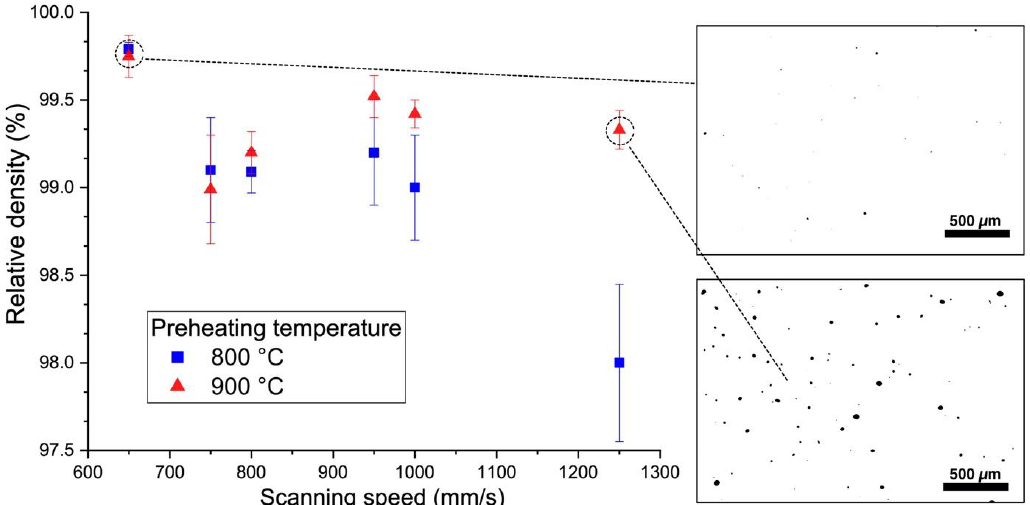
Figure 5. Effect of scanning speed and platform preheating temperature on the relative density of the samples fabricated from MAPS powder with cross-section images showing typical pore distribution. Materials 2020 , 13 , x